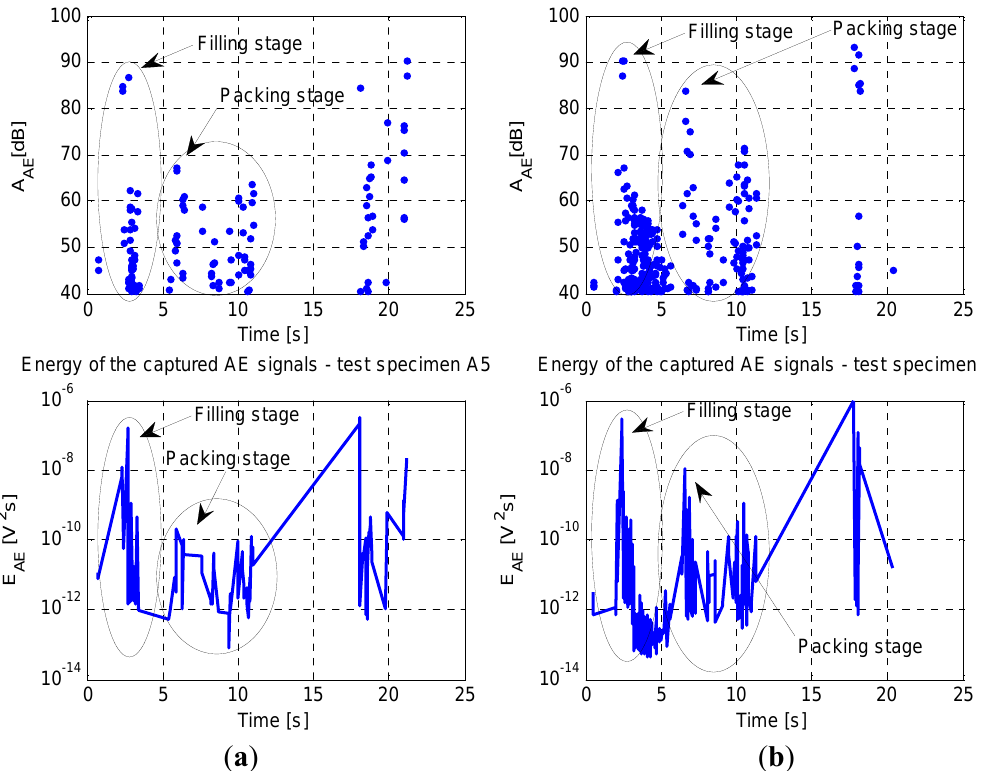
Figure 5. Intensities of AE events, amplitude, and energy of captured AE signals. ( a )